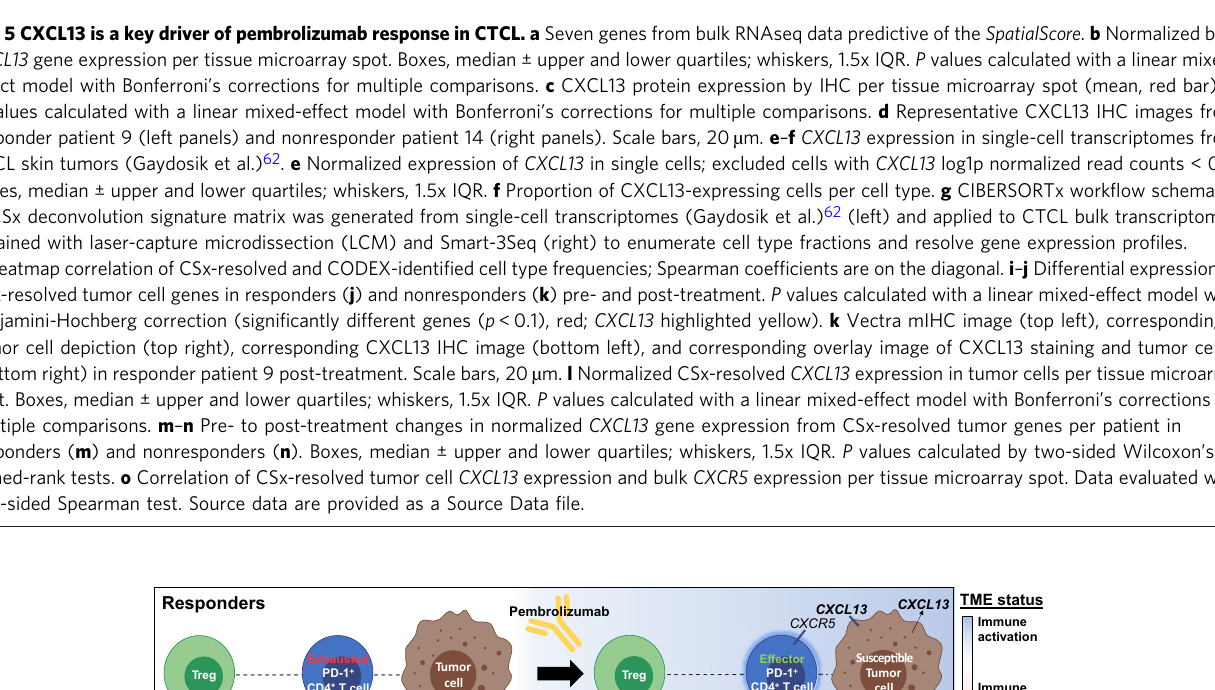
Fig. 6 Proposed mechanisms of pembrolizumab response in CTCL. Cartoon depicting proposed mechanisms of pembrolizumab response in therapy responders (top panel) and nonresponders (bottom panel) pre- and post-treatment. The functional immune status of the TME is represented by blue shading when activated and pink shading when suppressed. In nonresponders, the TME is continually immunosuppressed and persistently exhausted PD- 1 + CD4 + T cells are in closer proximity to potently suppressive ICOS + Tregs. Moreover, the tumor cells of nonresponders are less susceptible to pembrolizumab therapy. In contrast, responders have a neutral functional immune state pretreatment, which facilitates the baseline spatial organization that underlies a lower SpatialScore and immune cell priming and activation. This enables the transition from exhausted PD-1 + CD4 + T cells to effector/ cytotoxic GZMB hi PD-1 + CD4 + T cells following pembrolizumab therapy. Additionally, responder tumor cells are susceptible to PD-1 blockade and overexpress CXCL13 post-treatment, which chemoattracts effector PD-1 + CD4 + T cells toward tumor cells, providing a mechanism for the sustained clinical response seen in